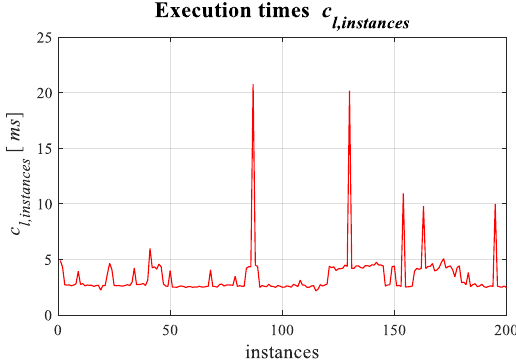
Figure 9. Execution times over the time instances.